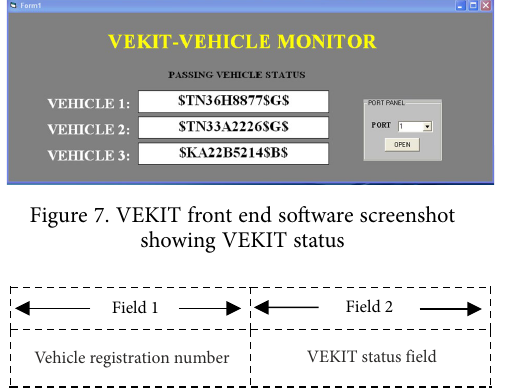
Figure 8. Vehicle status information pattern